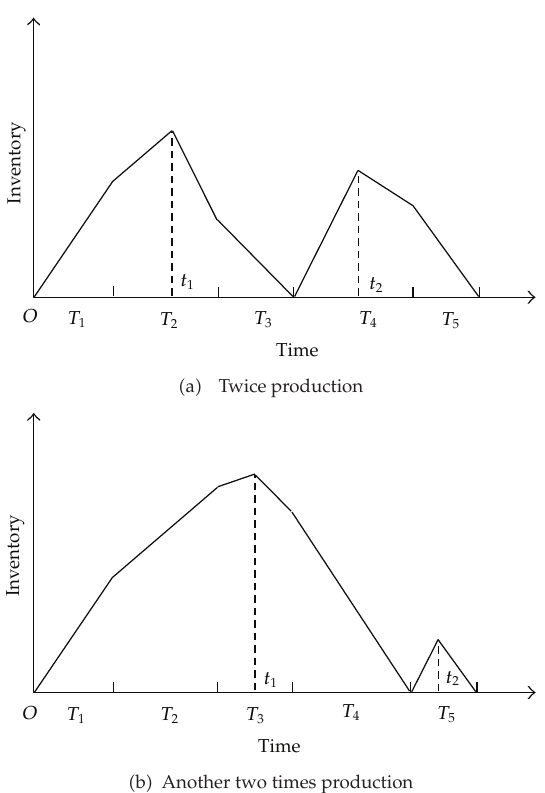
Figure 1: Production-inventory